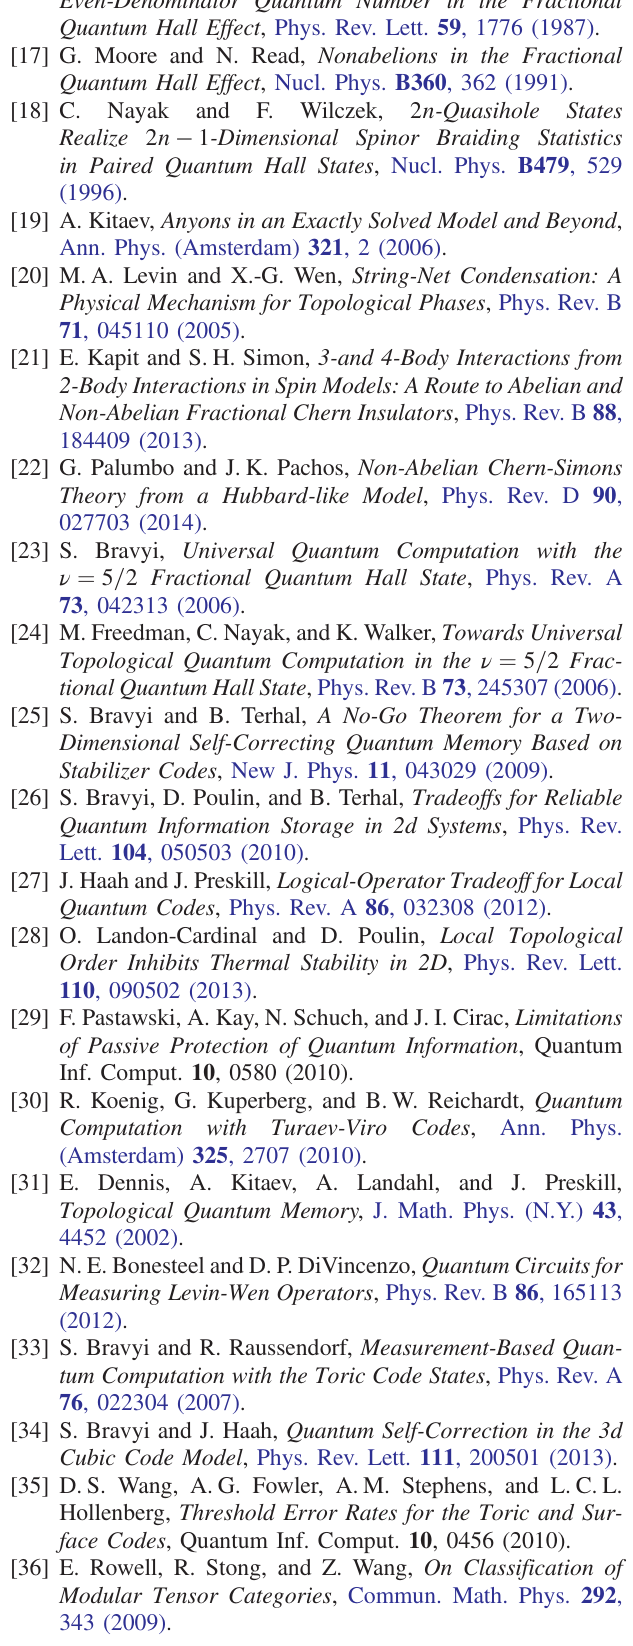
Finding Maximum Matching in General Graphs , in